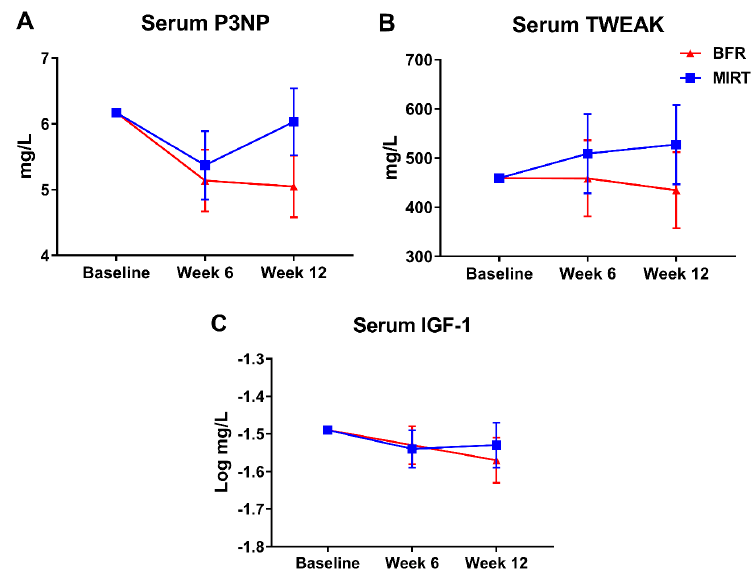
Figure 5. ( A – C ) Serum biomarkers of myogenic activity and collagen turnover including N-terminal peptide of procollagen type III (P3NP) ( A ), tumor necrosis-like weak inducer of apoptosis (TWEAK) ( B ), and insulin-like growth factor (IGF-1) ( C ). Values indicate estimated marginal mean ± SEM. Abbreviations: BFR—blood-flow restriction, MIRT—moderate-intensity resistance training.